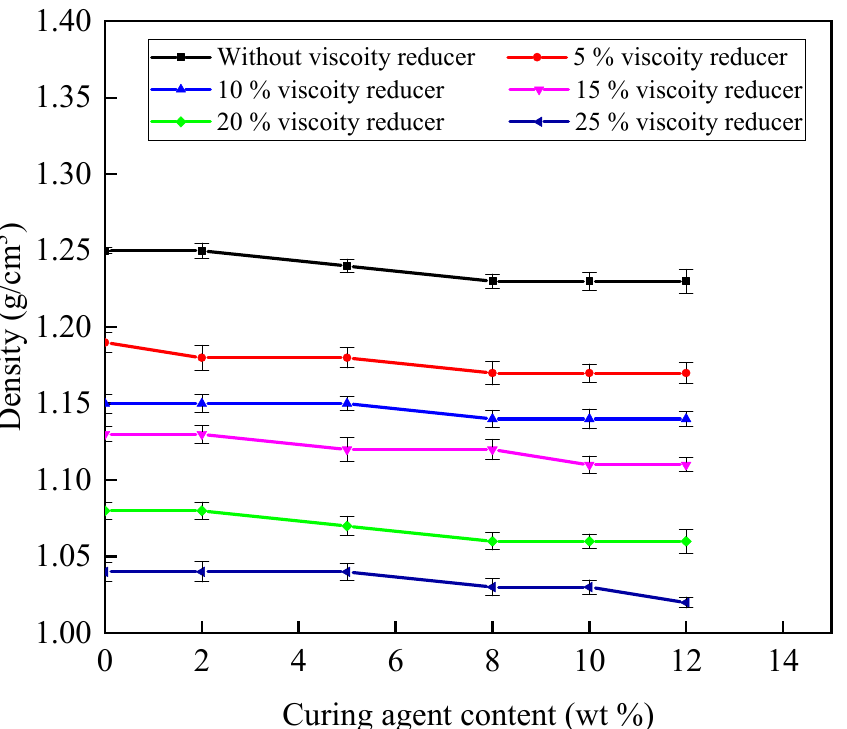
Figure 8. Density changes of the sealant system with different compositions.